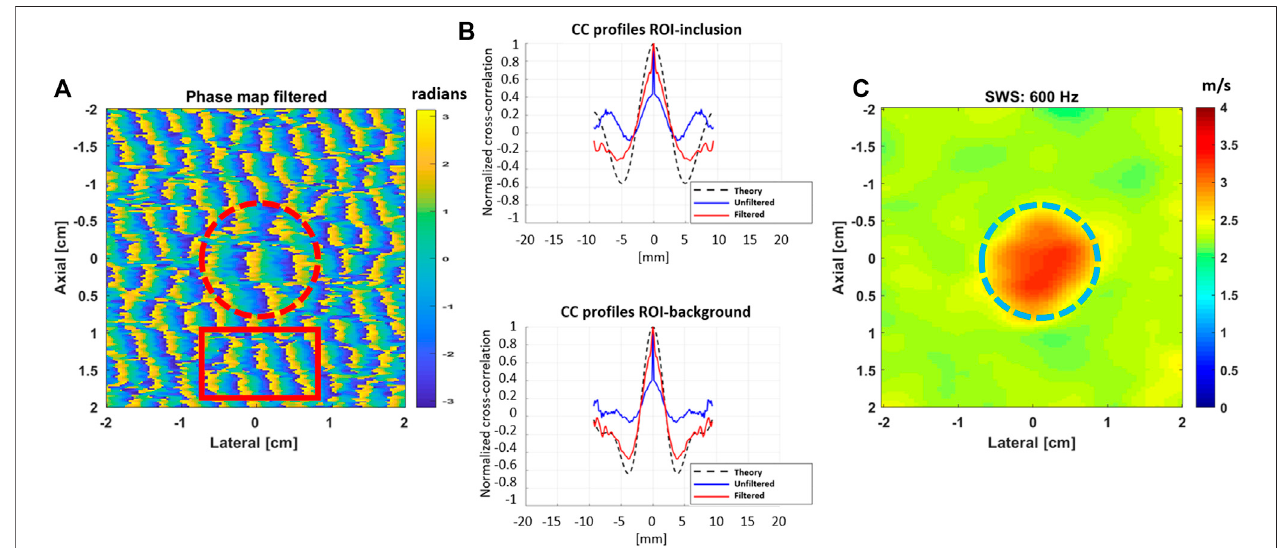
FIGURE 3 | (A) Simulated phase map in a 40 × 40 mm 2 region of a uniform elastic background with a stiffer inclusion after conducting a Monte Carlo analysis of reverberant shear waveswithfrequencyof f 0 (cid:2) 600 Hz andthe addition ofsigni fi cantwhitenoise.Theshearwavespeedsfor thebackground and theinclusionwere2.5 and3.5 m/s,respectively. (B) Thecross-correlationpro fi les,intheaxialdirection,areshownforthedashedcircle (top) andrectangle (bottom) redregionsshownin (A) . The pro fi les for the un fi ltered data show a peak at the center, a clear feature of the presence of noise. (C) Final SWS image obtained after the fi ltering process.